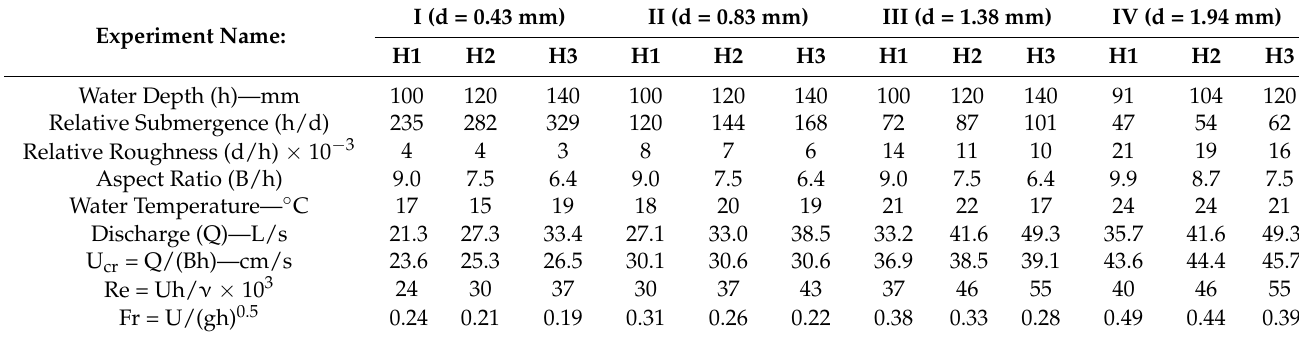
Table 2. Results and characteristics of experiments for incipient motion of sediment.